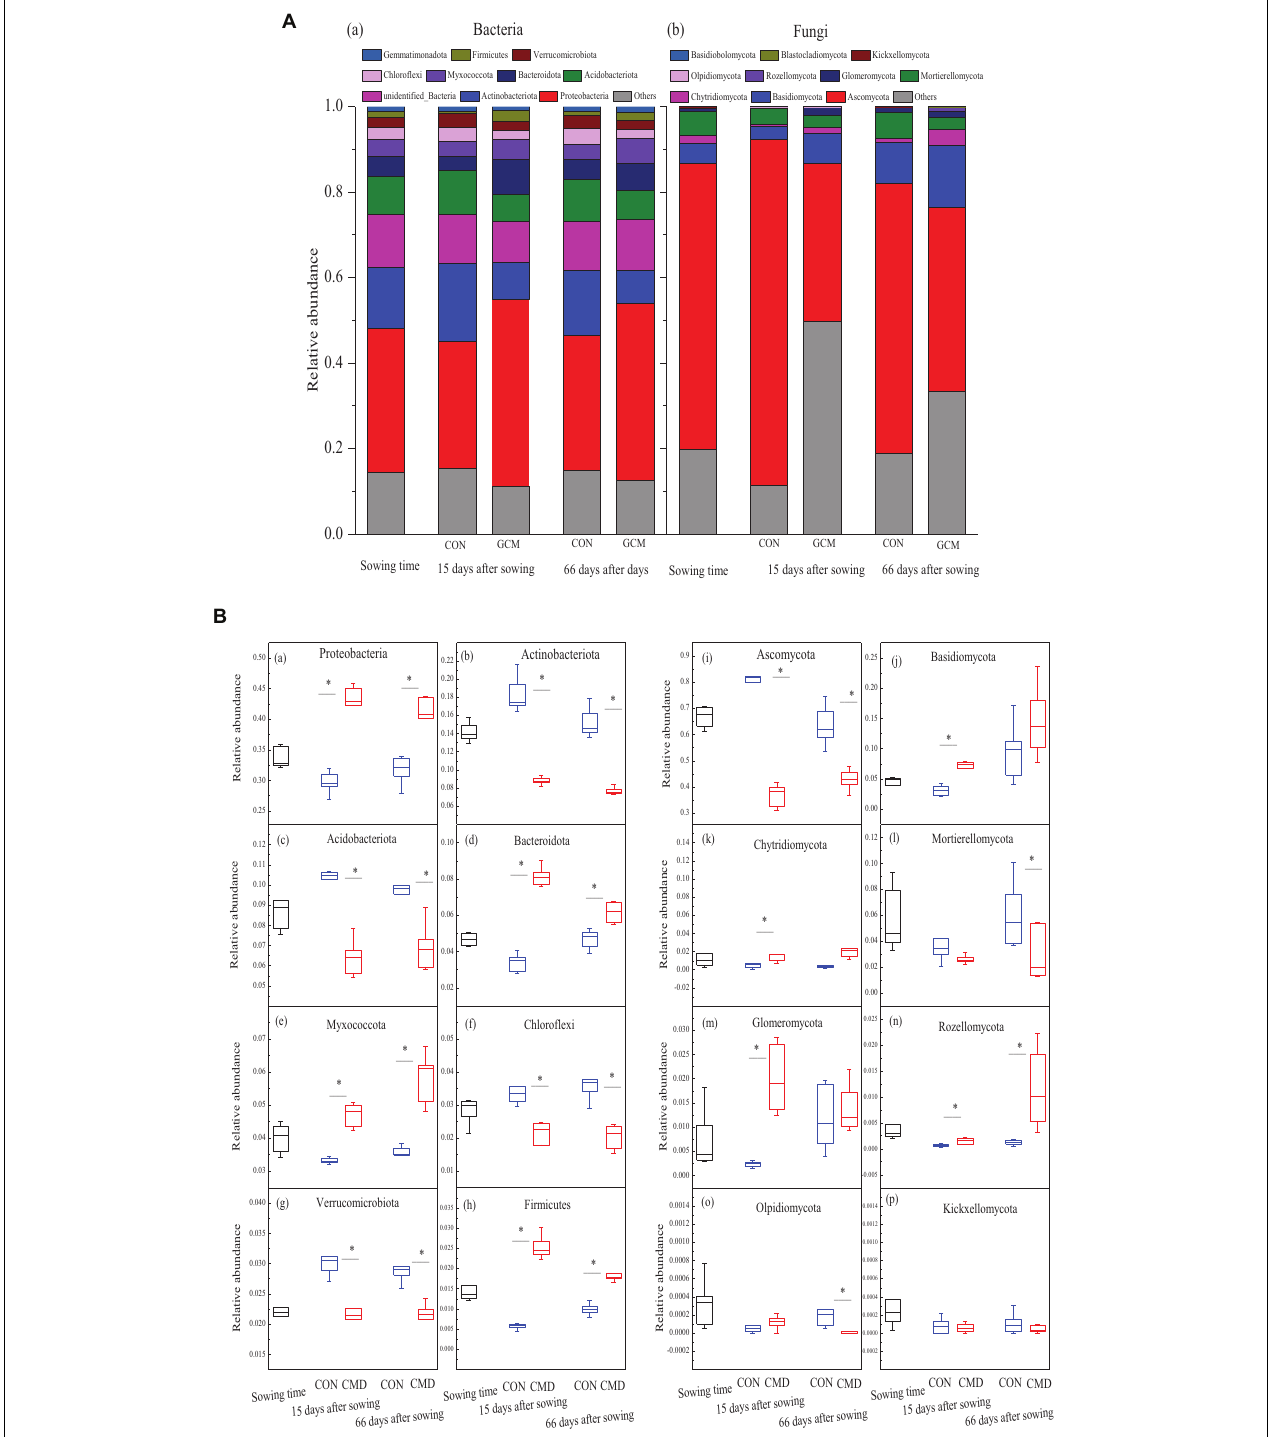
FIGURE 4 | Bacterial and fungal community composition at phyla level under CON and CMD at various growth stages. (A) Taxonomic distribution of bacteria (a) and fungi (b) in different rhizosphere soil. (B) Relative abundance of the eight most dominant bacteria (a–h) and fungi (i–p) in different rhizosphere soil. 0 days corresponds to sowing date; 15 days after sowing corresponds to plant trefoil stage; 66 days after sowing corresponds pustulation stage. CON, control; CMD, cattle manure deposition. Data represents mean ± SE ( n = 3). The data was based on a pot experiment in one year. All parameters were analyzed with SPSS version 16.0 (SPSS Inc. Chicago, IL, United States). Asterisk, on bar represent differences ( P < 0.05) between CON and CMD treatments for bacteria at each growth stage.